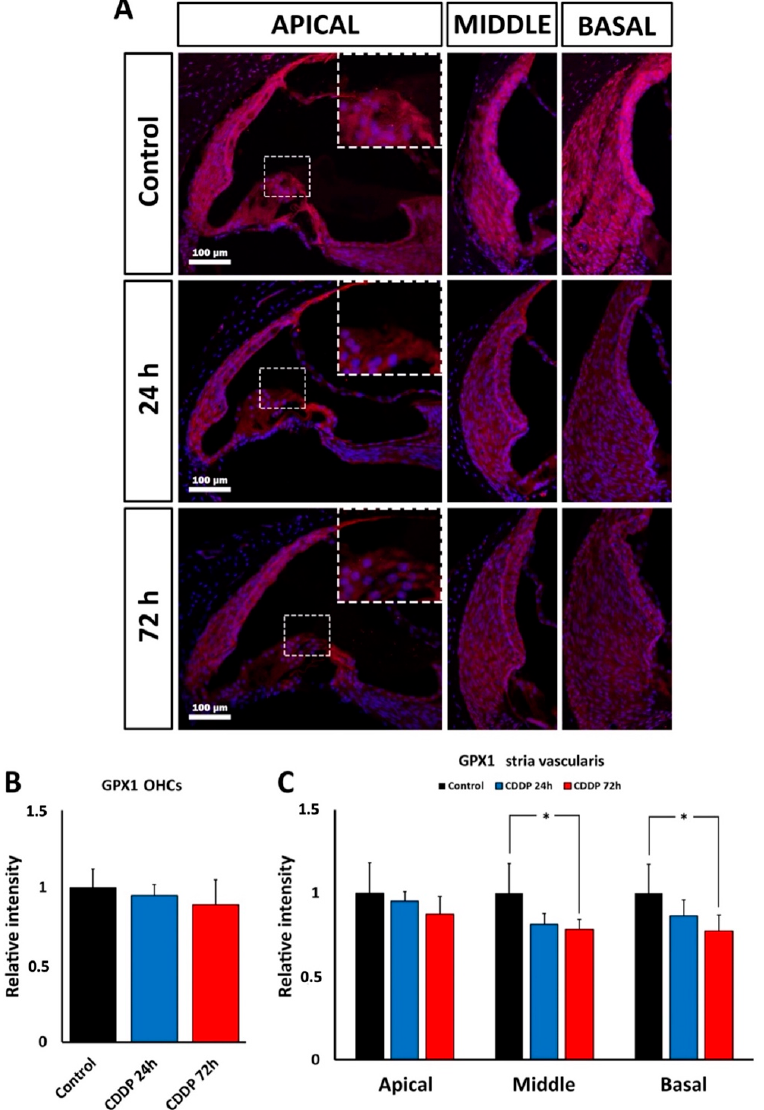
Figure 11. ( A ): Fluorescence immunolabeling for GPx1 (magenta) in the cochlea after 24 and 72 h of ototoxic cisplatin (CDDP) treatment and corresponding untreated control. Nuclei are counterstained with DAPI (blue). The vertical panel at the right of the figure shows immunolabeling for GPx1 in the OHC region of the apical turn (square, enlarged in the inset limited by broken line). The lateral wall with the stria vascularis can also be observed. The adjacent two panels show the lateral wall, including the stria vascularis of the middle and basal turns after 24 h and 72 h of cisplatin administration. ( B ): Relative intensity of GPx1 immunolabeling in the OHC region of the apical turn, 24 h and 72 h after administration of cisplatin. ( C ): Relative intensity of GPx1 immunolabeling in the stria vascularis of the apical, middle and basal turns, 24 h and 72 h after cisplatin administration. Asterisks indicate statistical significance values, as specified in Section 2.6, Materials and